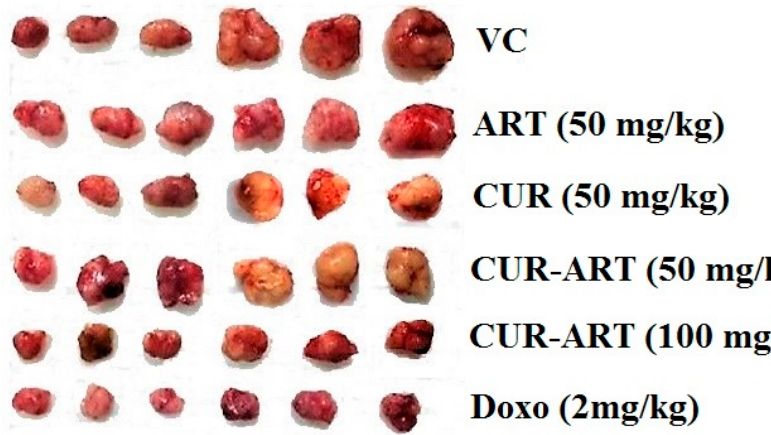
Figure 10. Tumor volume of Panc-1 xenograft model in nude mice during therapy under different drug treatments.